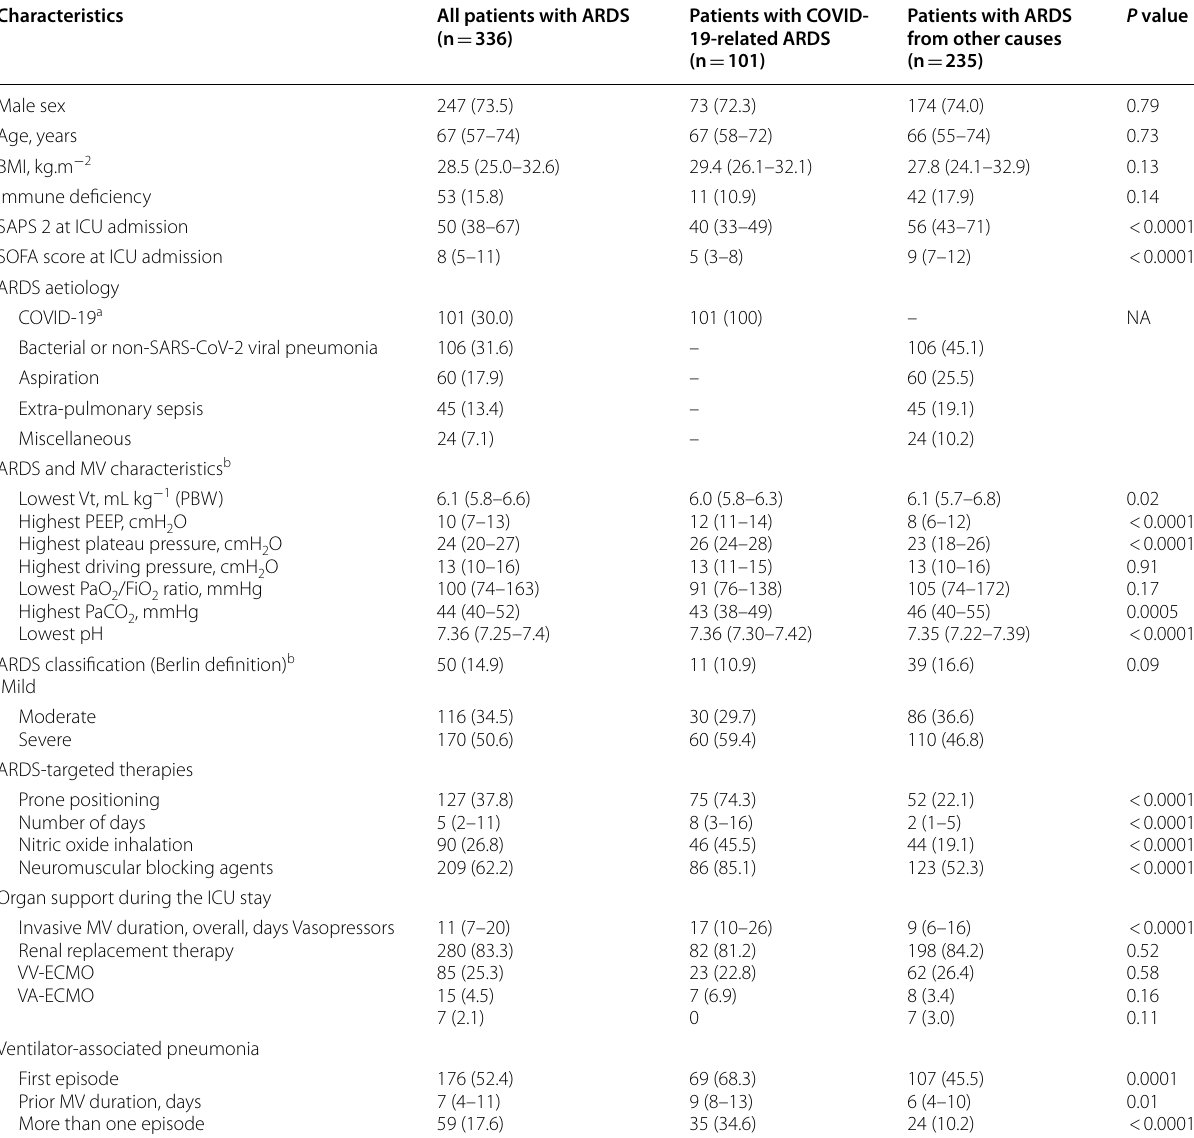
Table 1 Characteristics of the study